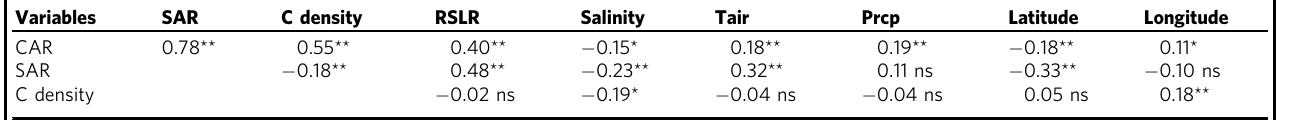
Table 3 Correlation coef fi cient ( r ) of tidal wetlands sediment variables with regional and climate